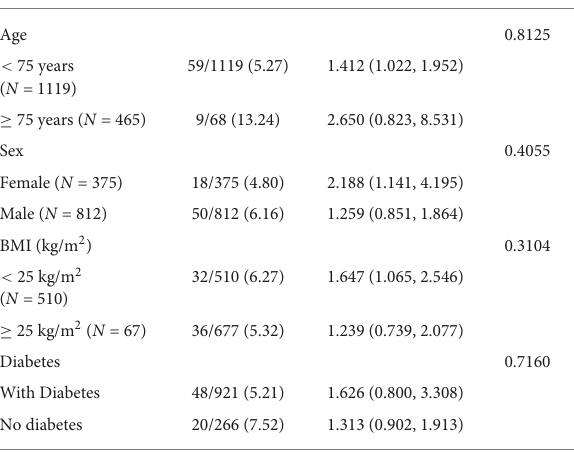
TABLE 4 The subgroup analysis of the association between NT-proBNP and MACE.